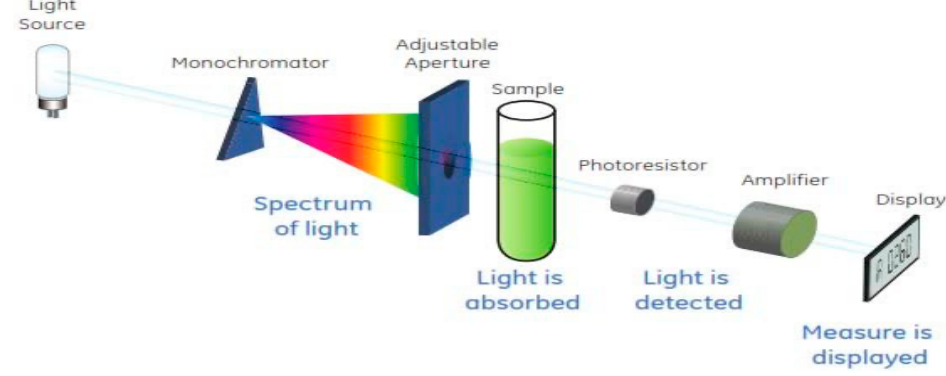
Figure 2. Schematic of the Spectrophotometer set-up.